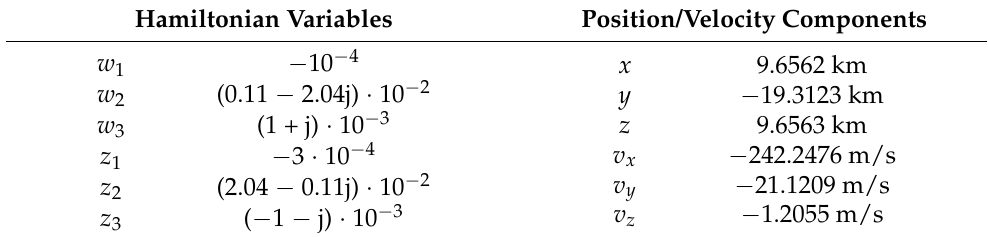
Table 15. Guidance strategy: initial state of reconnaissance satellite.